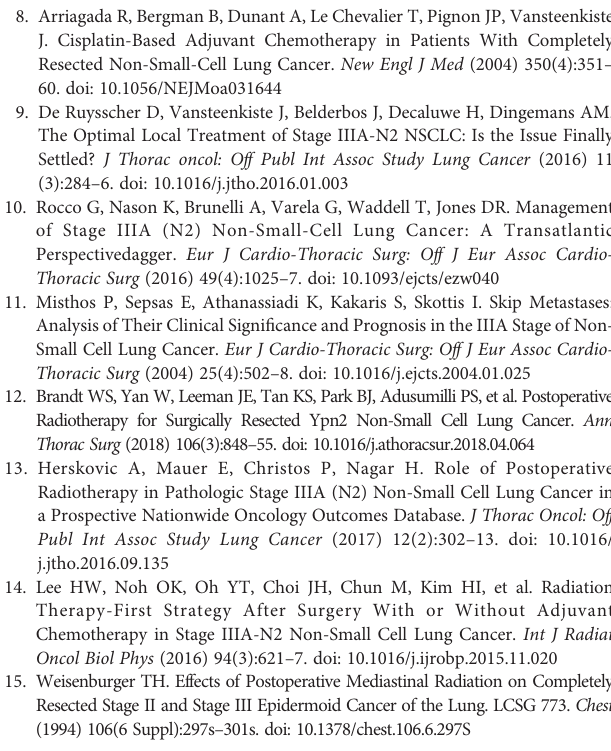
Supplementary Figure 1 | Consort diagram. NSCLC, Non – small cell lung